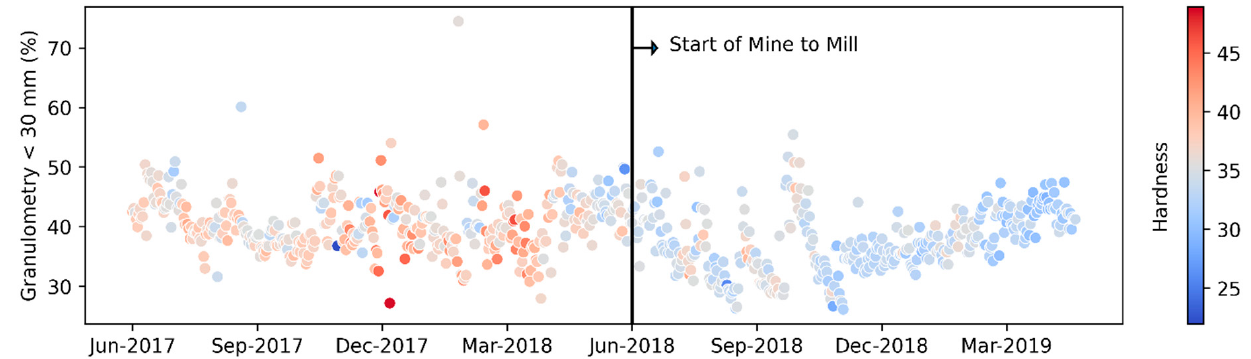
Figure 7. Variation of mineral hardness.